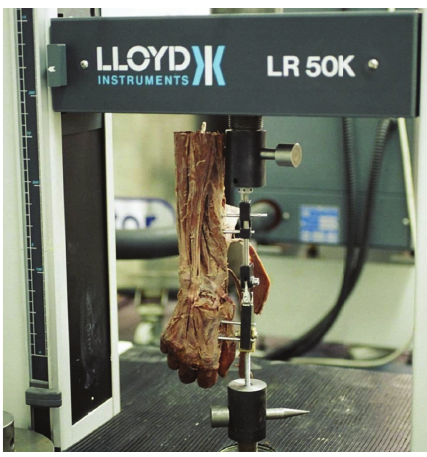
Figure 4: Loading machine and external fixator with a cadaver extremity positioned and ready for testing.